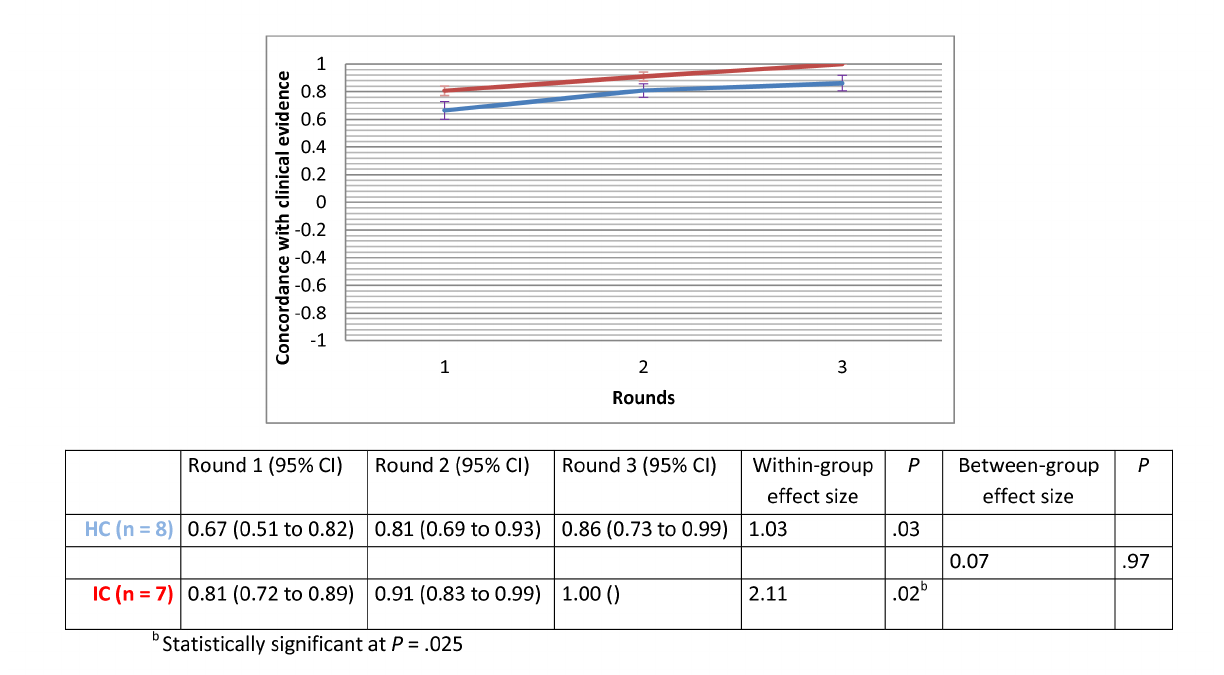
Figure 10. Concordance with clinical evidence for the therapeutic options